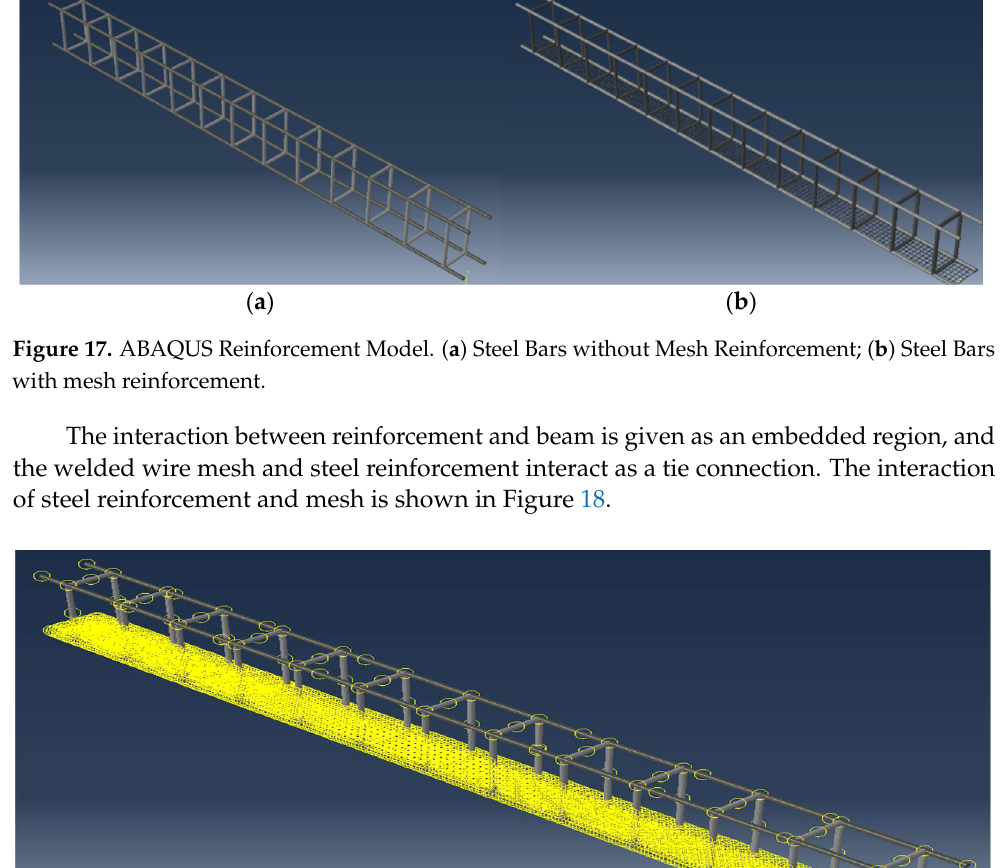
Figure 19. Displacement of Beam Reinforcement. The analytical model was created in ABAQUS. It is a FEM software widely used to analyse structural members in the engineering research field. It can take input of many concrete properties and gives various outputs per our requirement to obtain the analytical behaviour of lightweight and normal concrete beam. The CDPM parameters were as- signed for both LWC and NWC beams. 5.2. Analytical Tensile Behaviour of Beams The concrete tensile damage gives the output of the tensile damage inflicted on the concrete beam when loaded experimentally. The tension damage pattern obtained from